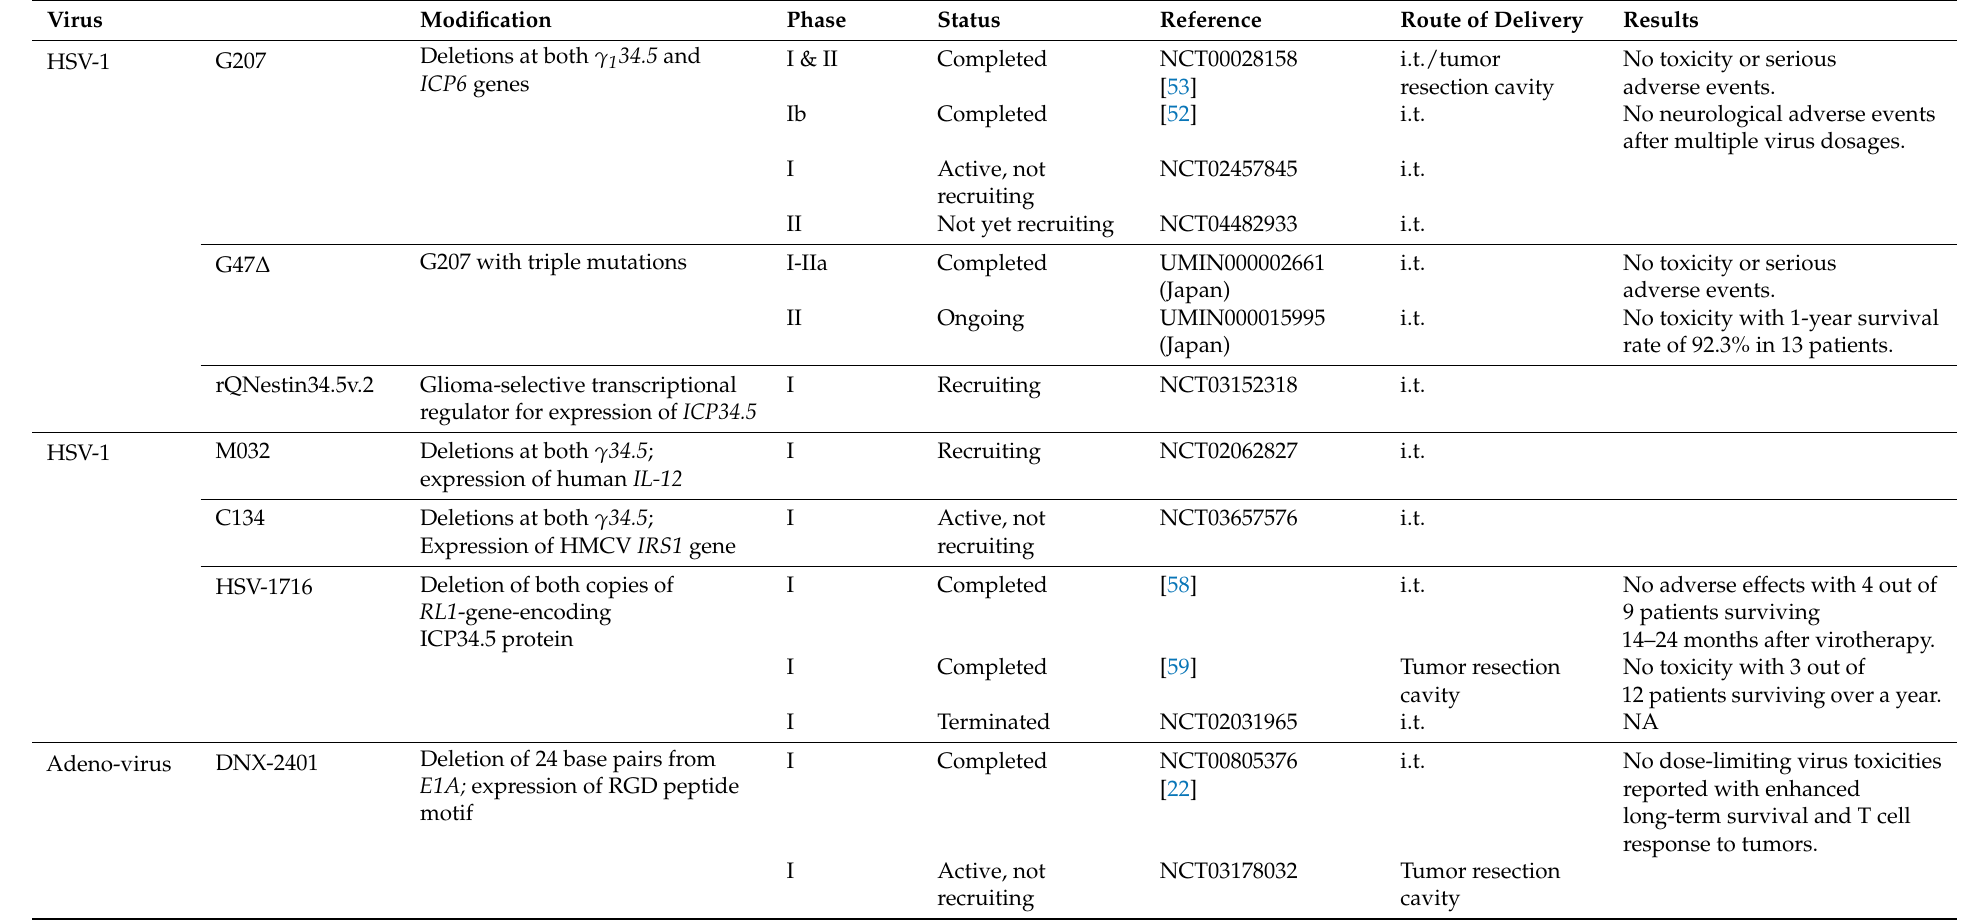
Table 1. Oncolytic viruses in clinical trials for treatment of malignant